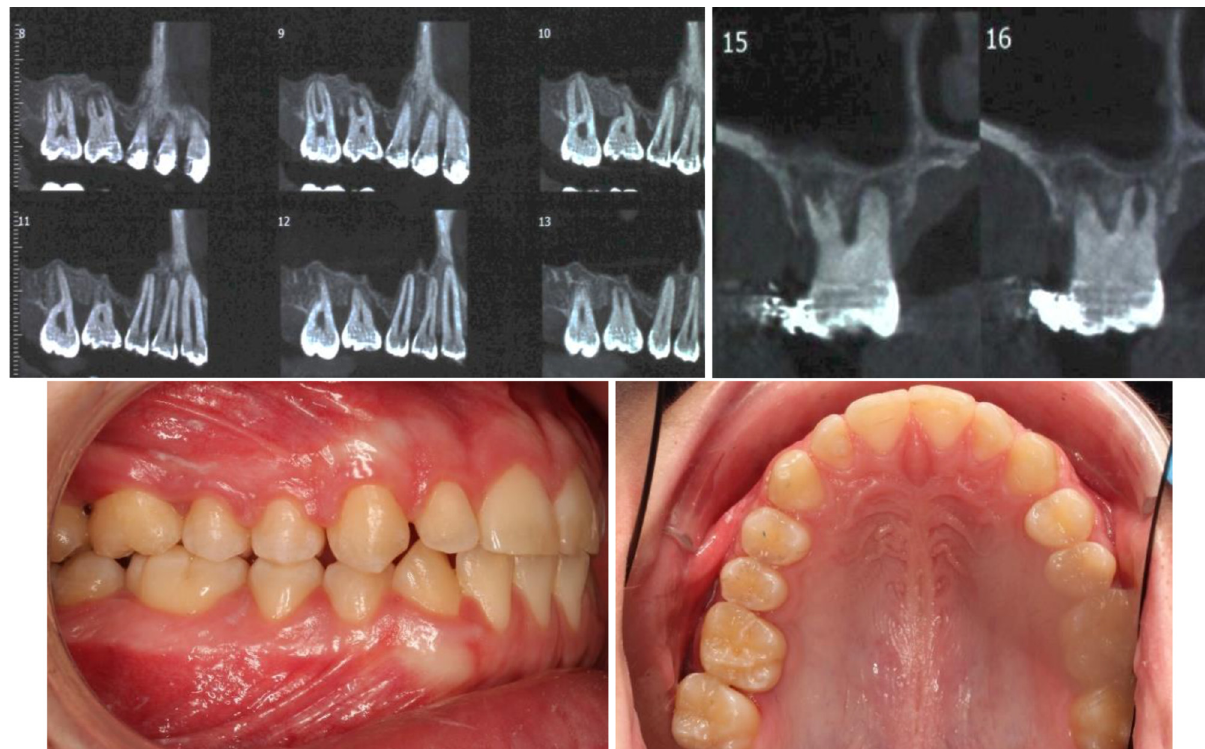
Fig. 5. 1 year follow up CBCT showing auto-transplant replaced, root formation at stage 9 of Nolla ’ s classi fi cation (equivalent to the germ 28 ’ s development). No oro-sinusal communication but a slight mesio-distal bone